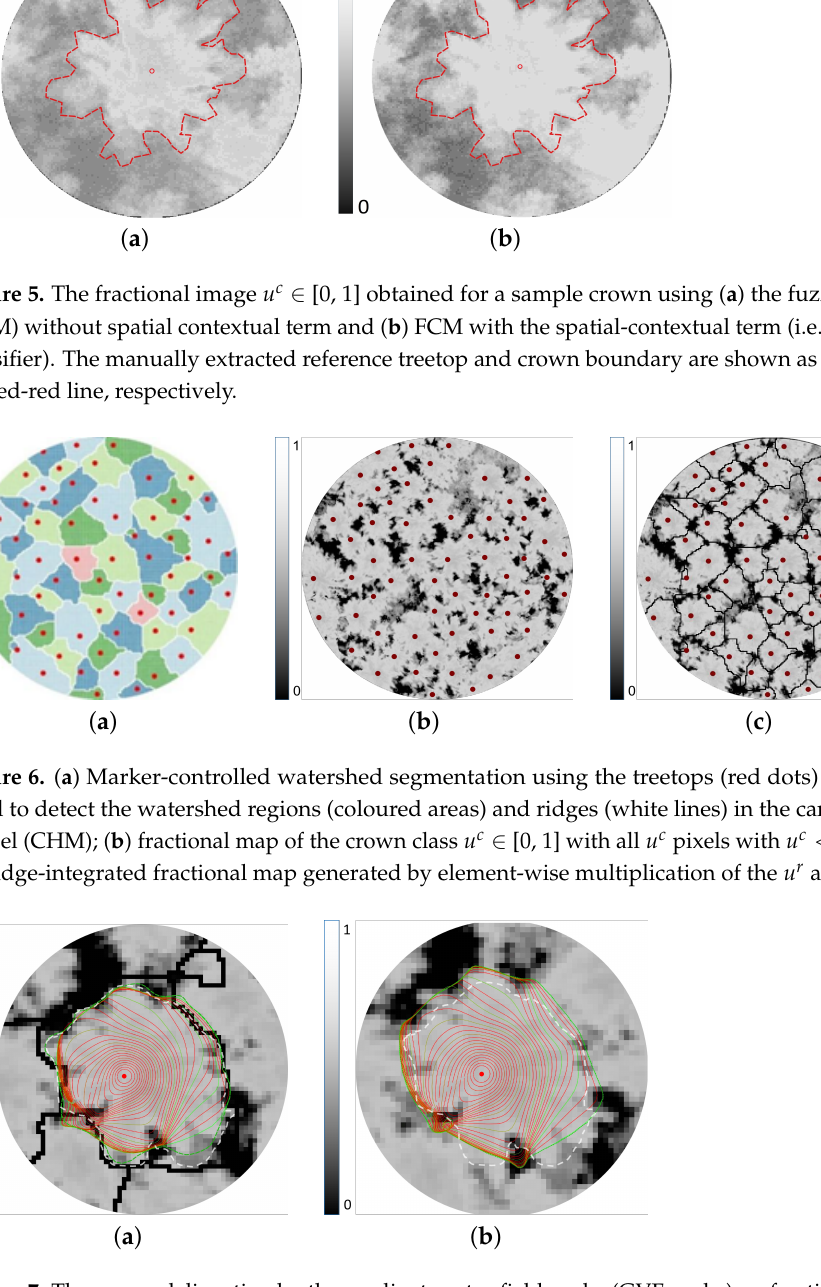
Figure 7. The crown delineation by the gradient vector field snake (GVF snake) on fractional images with and without ridge integration are shown in ( a , b ), respectively. A circular seed contour whose centre is placed at the treetop (red dot) is iteratively grown (red lines) using the GVF snake to detect crown boundary (dotted-green line). The reference crown boundary is shown in white-dotted